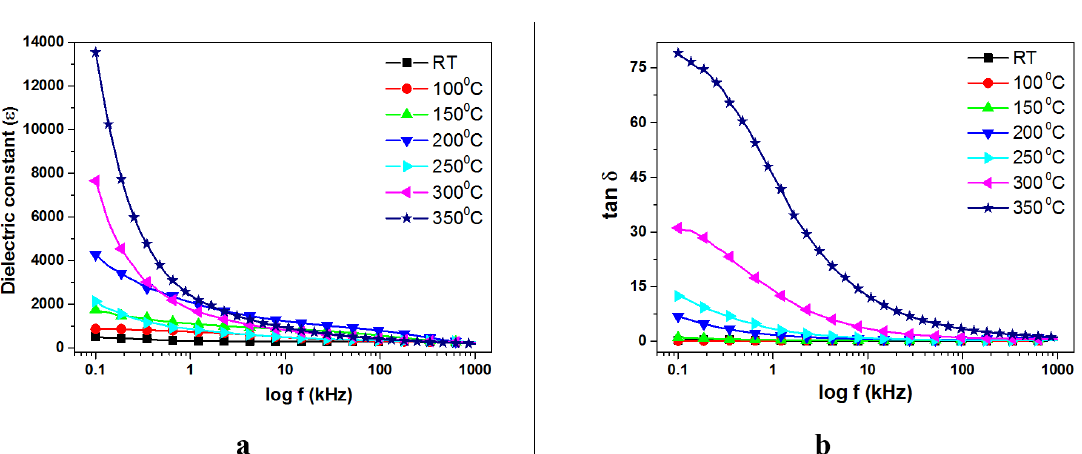
Fig. 2(a-b) Variation of dielectric constant (ε) and loss tangent (tan δ) of Bi